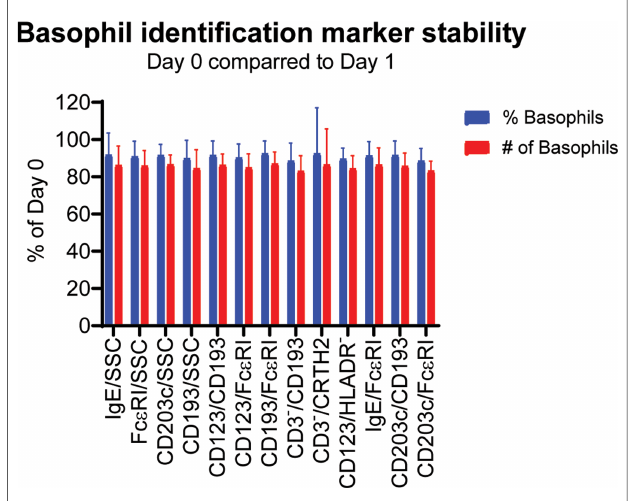
FIGURE 2 Stability of the different basophil identi fi cation markers. Whole blood from 9 donors was collected in heparin tubes and the expression of the markers were measured by fl ow cytometry after 0 – 4 h (Day 0) and again after 22 – 26 h (Day 1) using the gating strategy shown in Figure 1 . The blood was stored at room temperature (18 – 25°C). The % basophils of WBC as well as the total number of basophils identi fi ed were measured. The results for Day 0 are set to 100% and the results for Day 1 are normalized accordingly. Student ’ s t -test paired, n